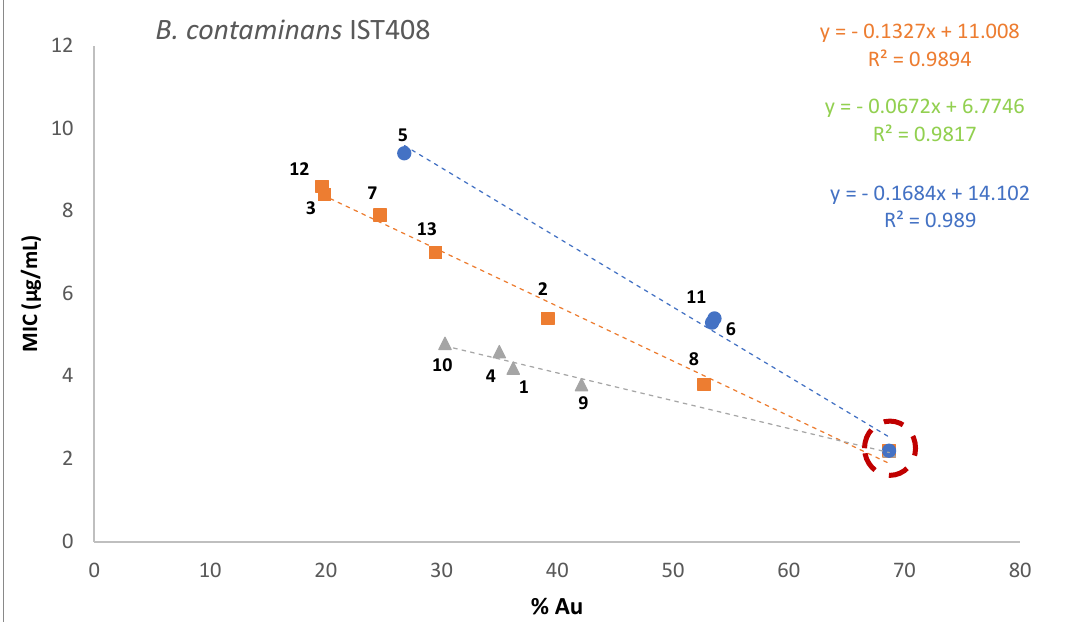
Figure 3. Relationship between gold content of complexes and their MIC values against B. contaminans (numbers close to the marks refer to the number of the complexes, see Table 1).